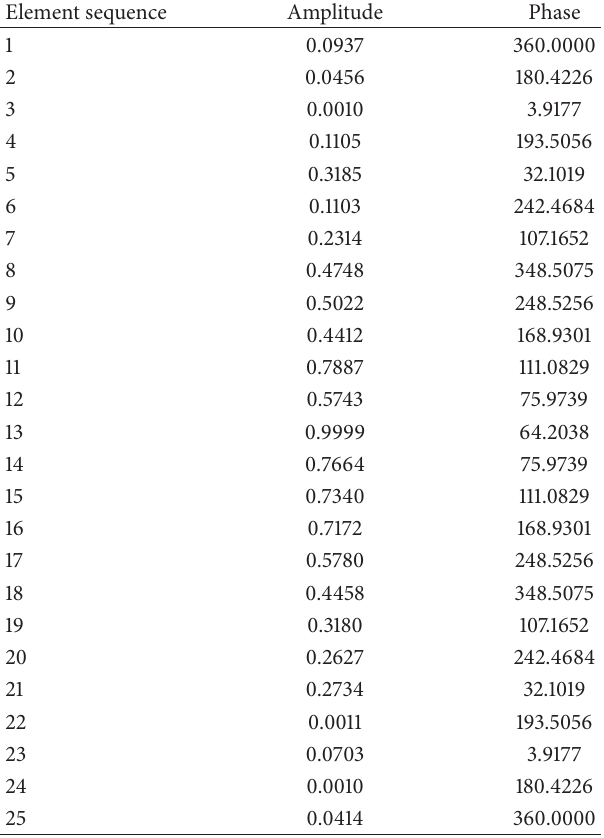
Table 3: Each element amplitude and phase derived from MGSA-